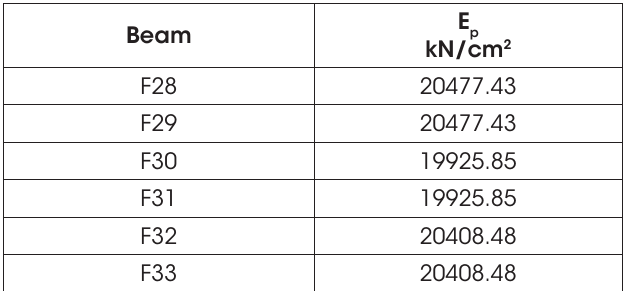
Table 8: Additional data for the beams tested by MATTOCK [8]